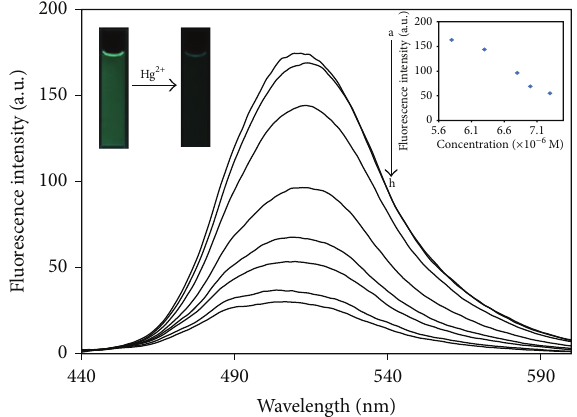
Figure 2: Fluorescence spectra ( 𝜆 426 nm) of 1 (0.15 𝜇 M) in ex CH 3 CN as a function of [Hg 2+ ]. a: 0M, b: 4.6 𝜇 M, c: 6.3 𝜇 M, d: 6.8 𝜇 M, e: 7.0 𝜇 M, f: 7.9 𝜇 M, g: 10 𝜇 M, and h: 19 𝜇 M. (The inset shows intensity of sensor 1 versus concentration of Hg 2+ .)